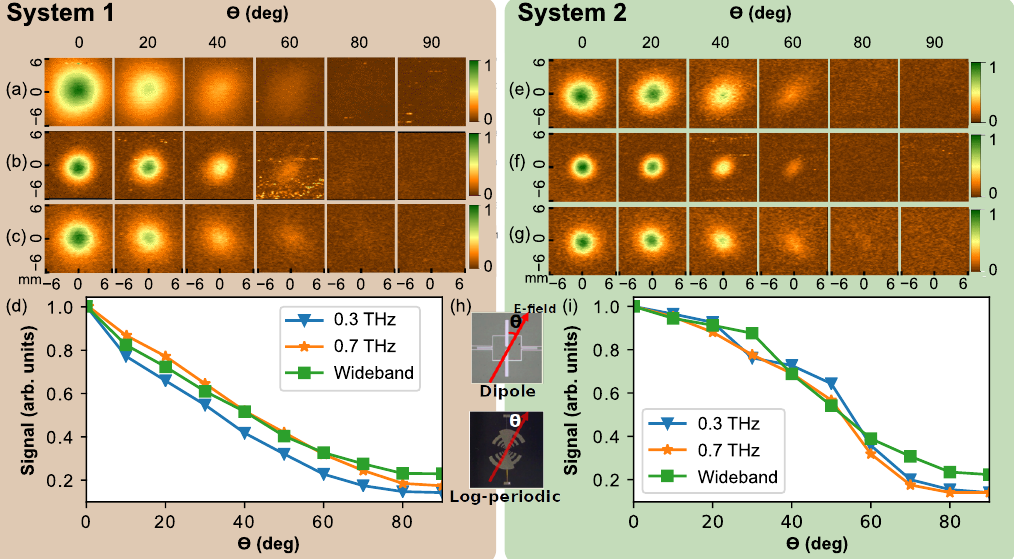
Figure 5. Polarization dependencies of the radiation patterns at various distances along the beam propagation axis recorded by different type of antenna-designs coupled Ti- µ bolometers. Panels ( a , e )—0.3 THz; panels ( b , f )—0.7 THz; panels ( c , g )—wideband Ti- µ bolometer. Panels ( d , i )—the angular dependencies of the signal at the pattern center normalized to the signal at θ = 0 deg, for System 1 and System 2, respectively. Panel ( h ) depicts rotation angle θ with respect to the Ti- µ bolometer axis.